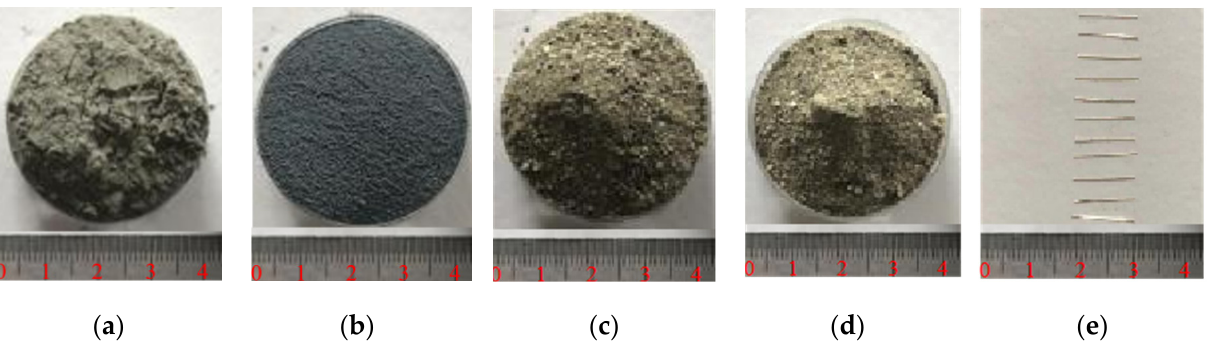
Figure 1. Materials used in the production of concrete. ( a ) Cement; ( b ) Silica fume; ( c ) Sand; ( d ) GT; ( e ) Steel fiber.